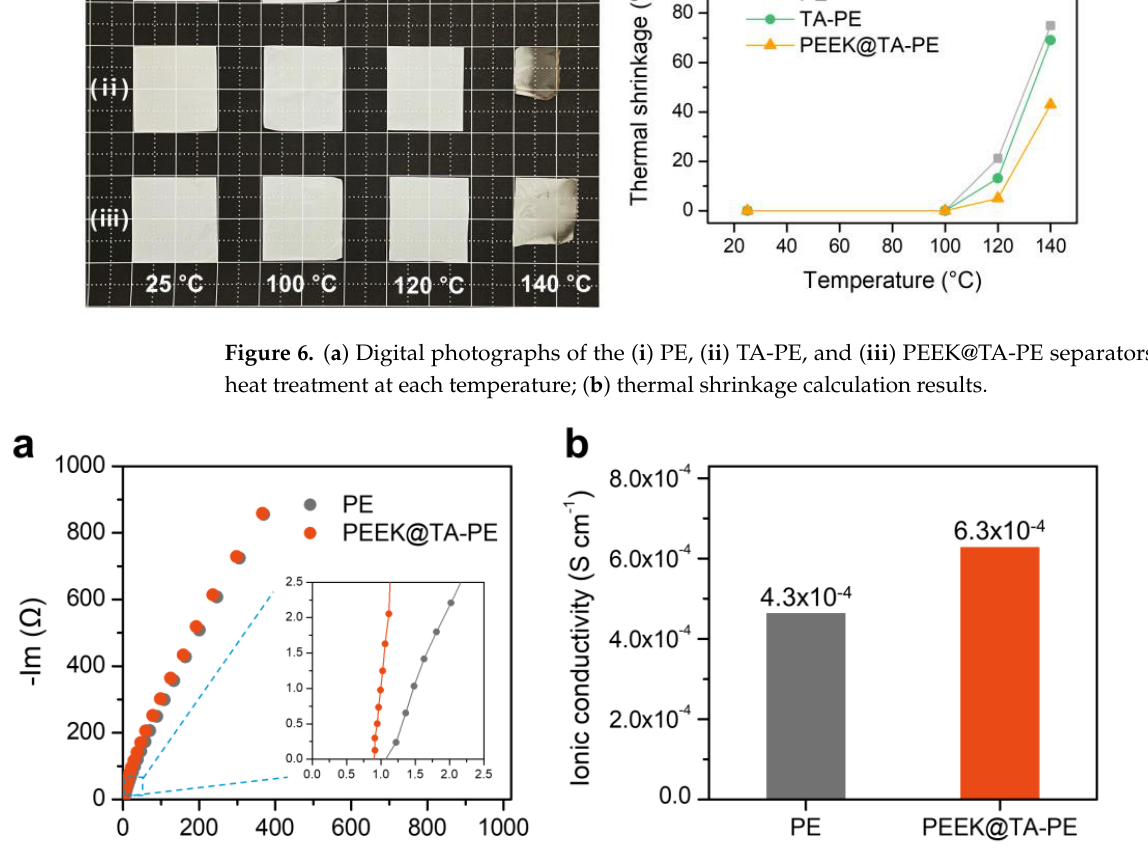
Figure 6. ( a ) Digital photographs of the ( i ) PE, ( ii ) TA-PE, and ( iii ) PEEK@TA-PE separators after heat treatment at each temperature; ( b ) thermal shrinkage calculation results.